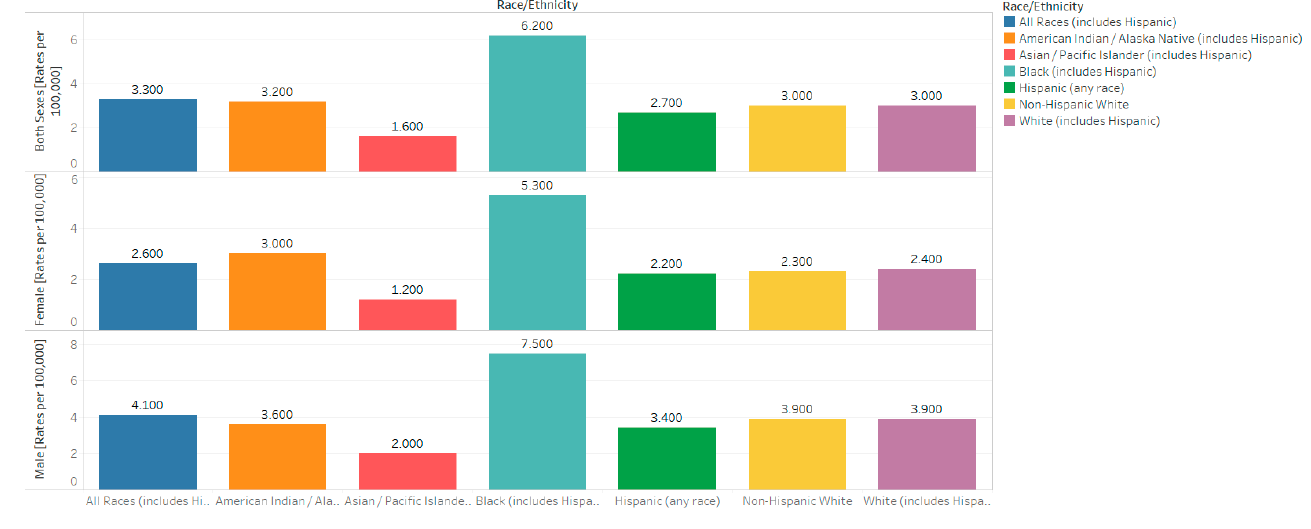
Figure 6. Bar chart showing the United States’ 5-year age-adjusted mortality rates from 2013–2017 for all races (including Hispanics). Created with Tableau 2019.2. Data source: SEER*Explorer [11].